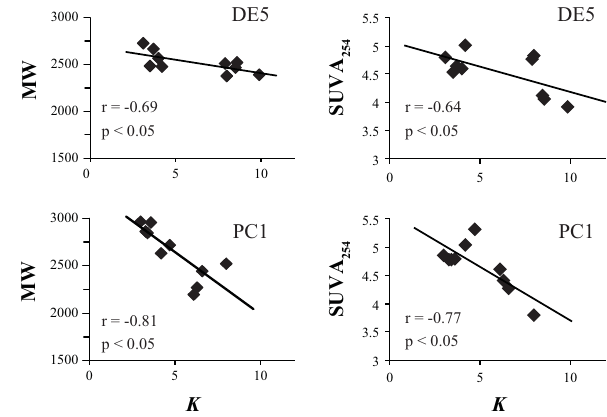
Fig. 6. Correlations between photodegradation rate constant, K (m 2 GJ − 1 ), molecular weight, M W (Da), and SUVA 254 (m − 1 mg − 1 L) in DE5, PC1 and HP4 streams during winter months when the catchments were snow covered.